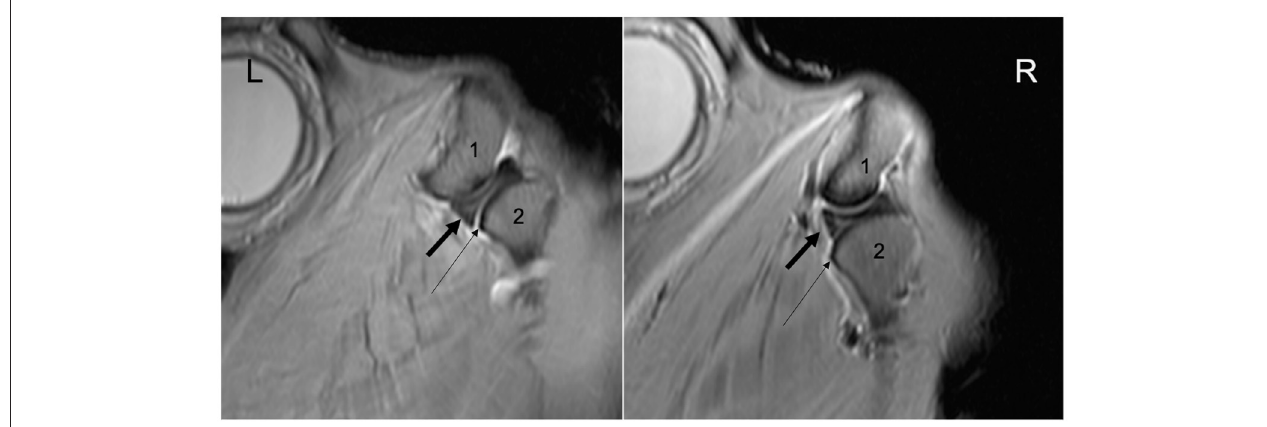
FIGURE 3 | Bilateral TMJ oblique sagittal T2*W image of the 26-year-old Arabian gelding indicating mild rostral dislocation of the left intra-articular disc compared to the right. L, left; R, right. 1, temporal bone; 2, mandibular condyle. Note the difference in relative position between the rostral margin of the intra-articular discs (thick black arrow) and the rostral margin of the mandibular condyles (thin arrows).